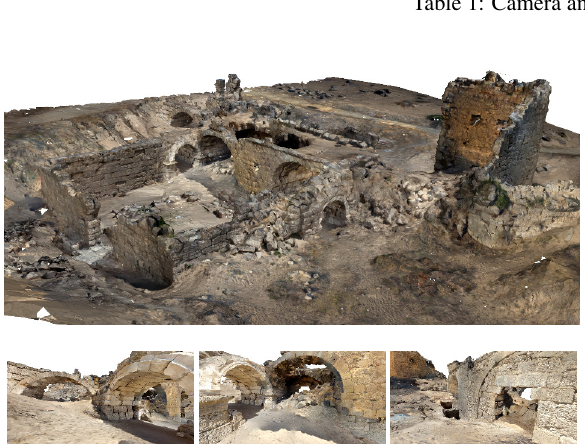
Figure 7: Rendered views from an automatically reconstructed and textured 3D model of an archaeological excavation site in Turkey, obtained from 4.722 terrestrial and aerial images cap- tured with 3 different cameras from the air and from the ground.